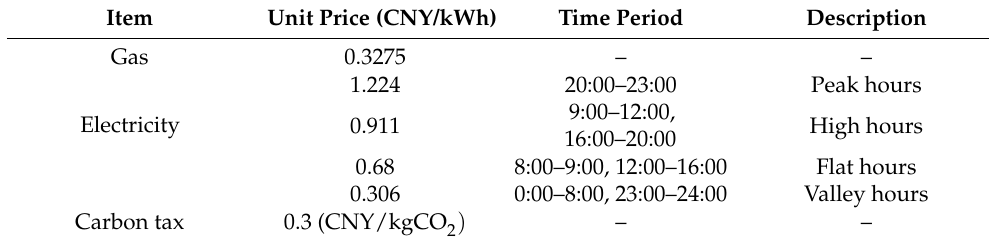
Table 7. Energy price and carbon tax Reproduced from [50–52].